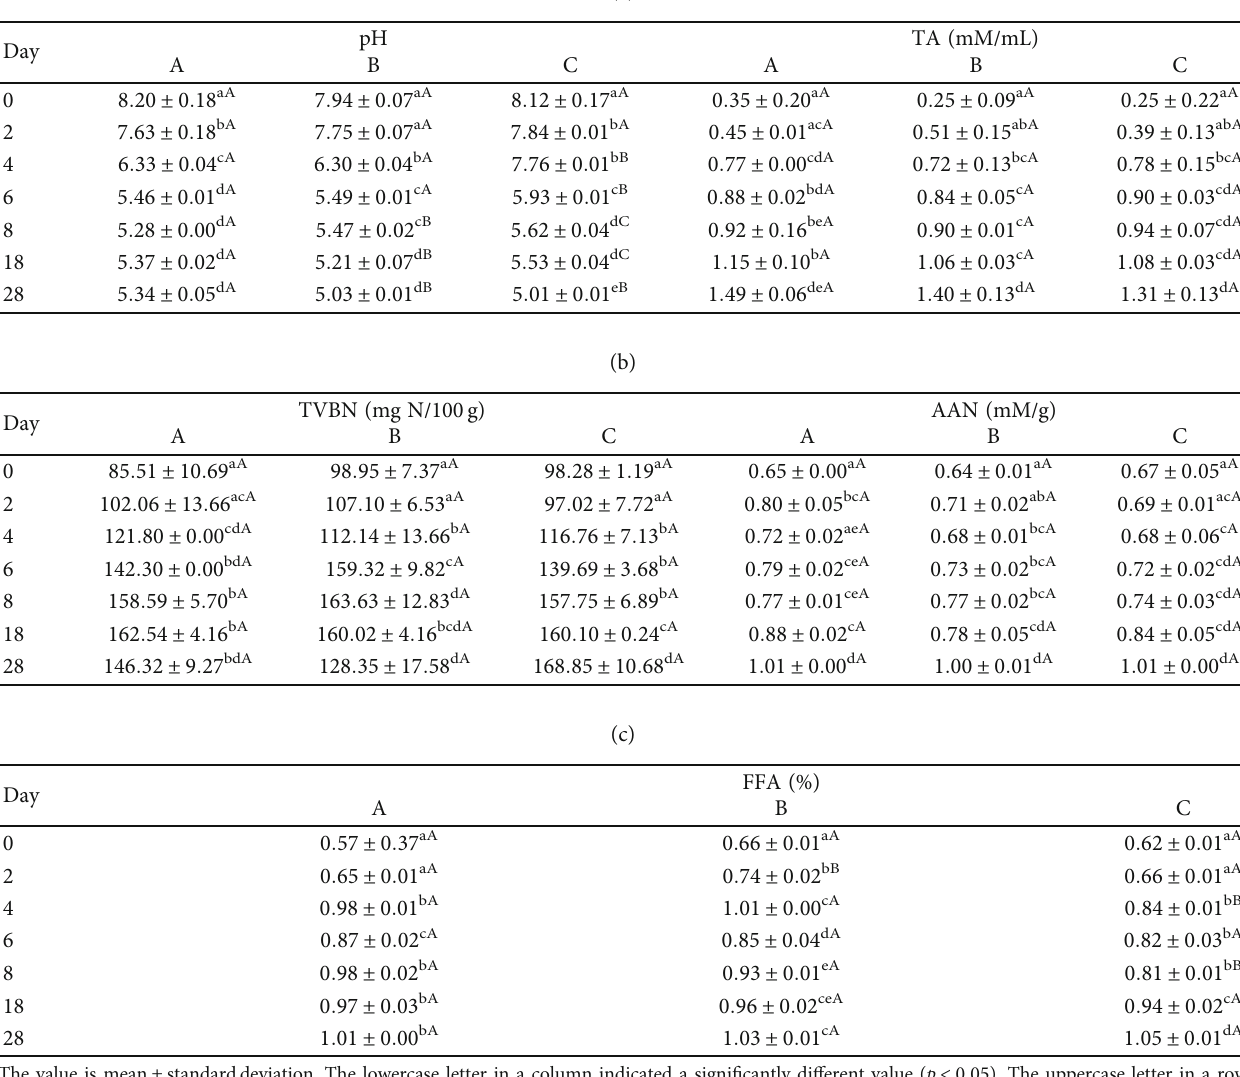
Table 2: Physocochemical changes of recipes A, B, and C during the fermentation. (a)